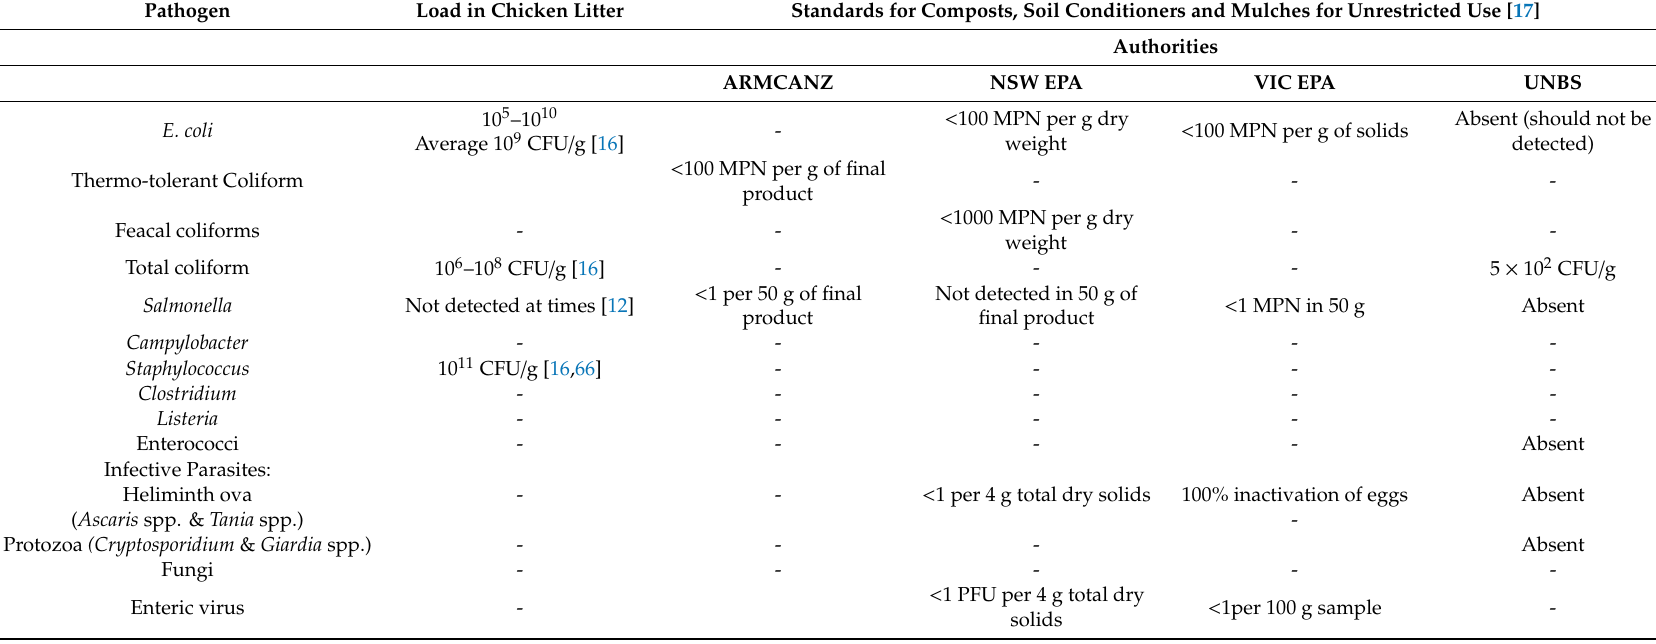
Table 5. Pathogen load in chicken litter and standards for composts, soil conditioners, and mulches for unrestricted use. Pathogen Load in Chicken Litter Standards for Composts, Soil Conditioners and Mulches for Unrestricted Use [17] Authorities ARMCANZ